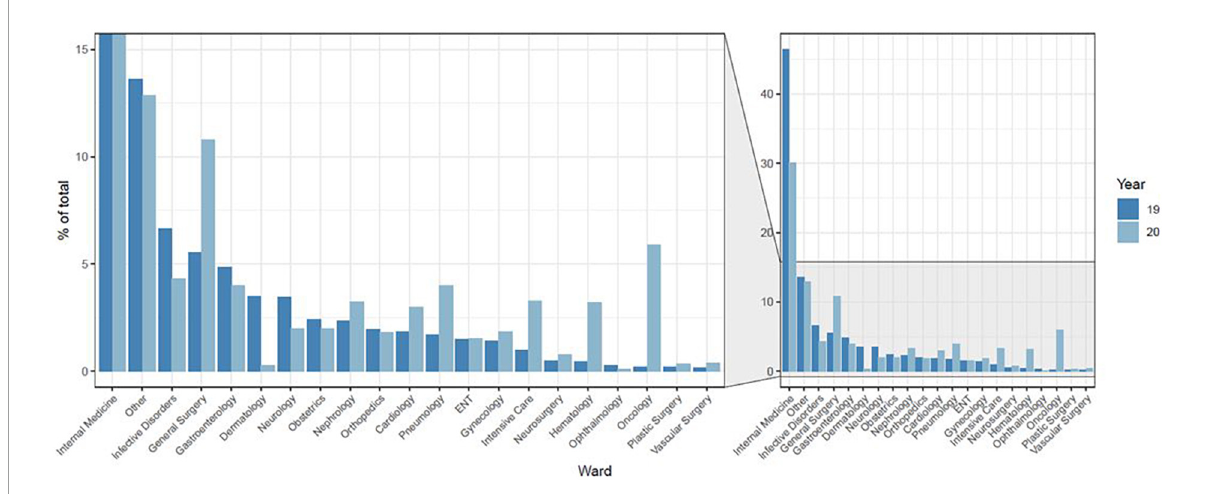
FIGURE2 Distribution of referrals according to the